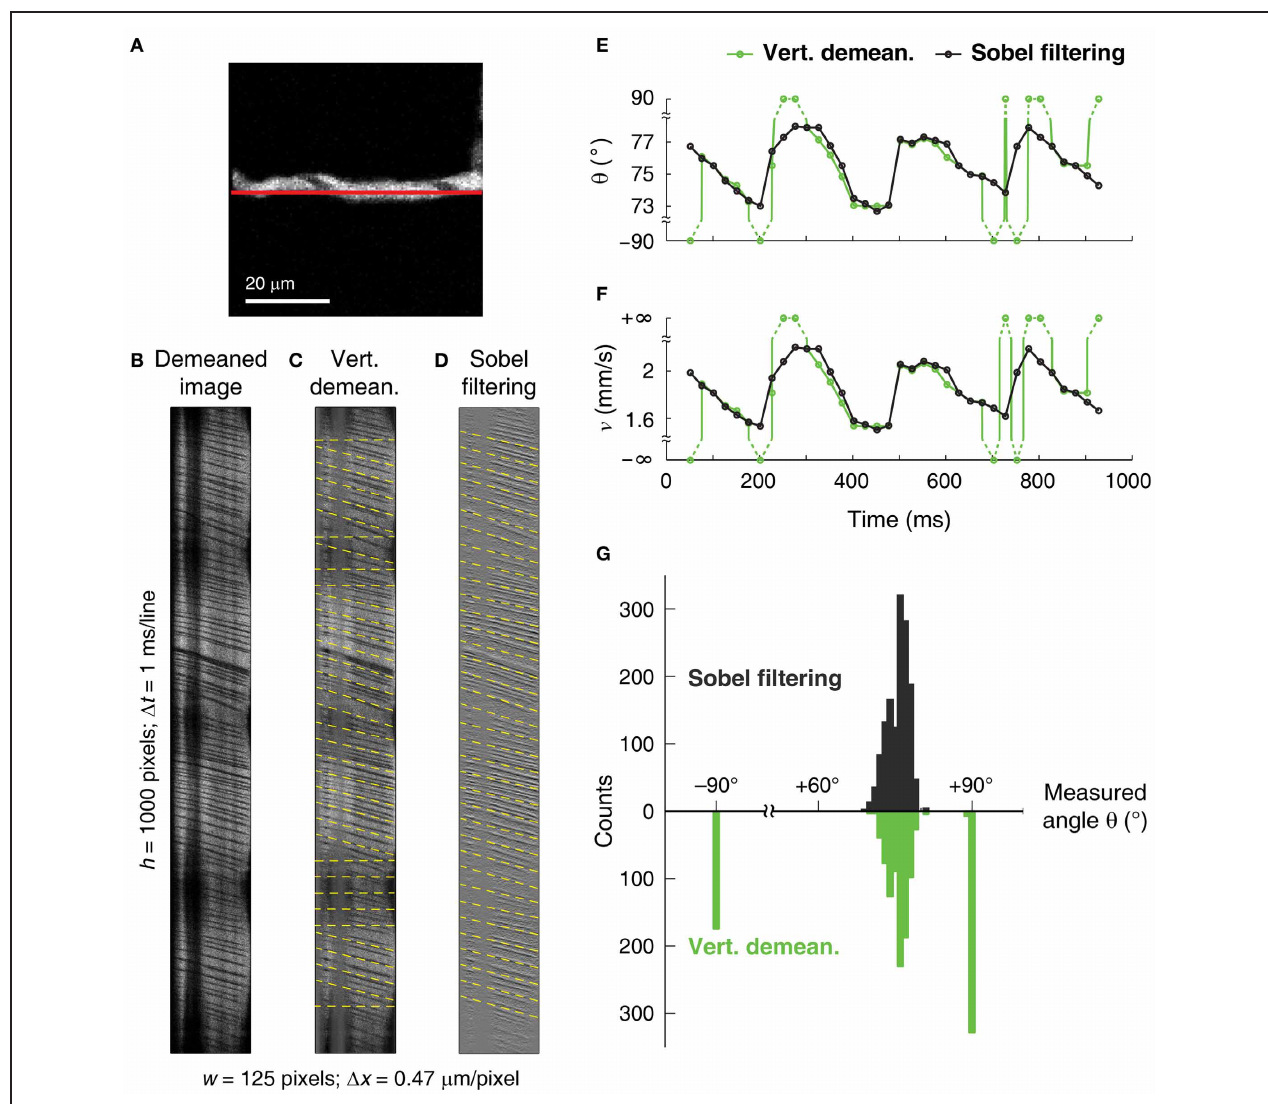
FIGURE 9 | Improvement in the angle measurement using Sobel filtering on an image with motion artifacts. (A) Reference full-frame image of a 5 μ m diameter microvessel in the cat visual cortex. The line-scan trajectory is shown as a red line. (B) Line-scan image from the microvessel. Continuous dark vertical bands are due to line-scan path going out of the vessel and the intermittent horizontal dark bands are related to brain motion due to transmitted heartbeat movements. (C) Vertically (temporally) demeaned image of (B) leads to incorrect angle and velocity estimation at some image segments (see horizontal dashed yellow lines). Note the suppression of time-invariant vertical bands, but virtually unchanged time-varying horizontal bands. (D) Sobel filtered image of (B) leads to suppression of both types of artifacts and enhancement of RBC streak edges. Dashed yellow lines represent